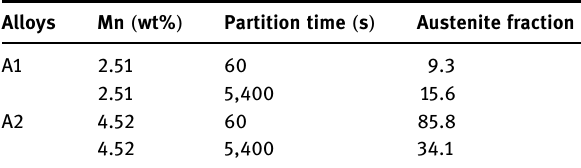
Table 2: Retained austenite fraction of wear - resistant alloys ( volume, % )